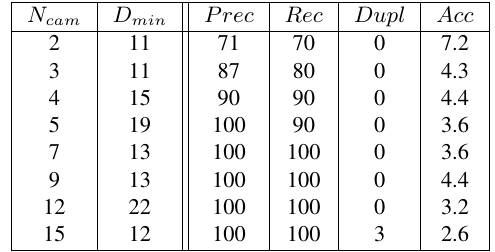
Table 1: Results on synthetic dataset for increasing N cam with N 3 D = 10 , σ = 4 cm and E